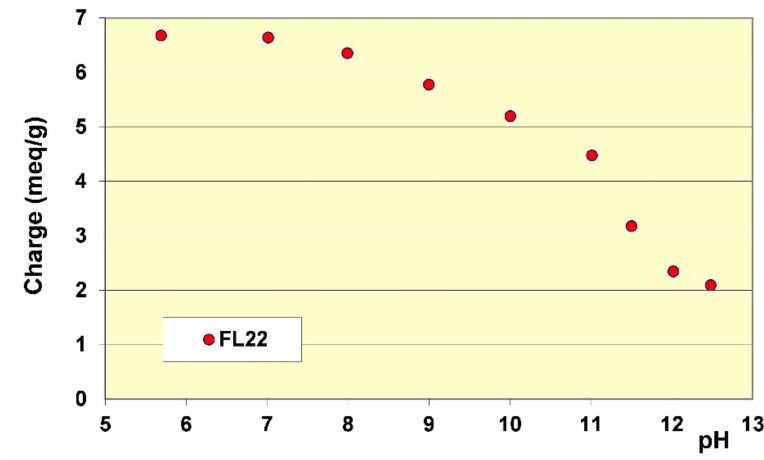
Figure 6. Variation of cationic charge on FL22 polymer as a function of the